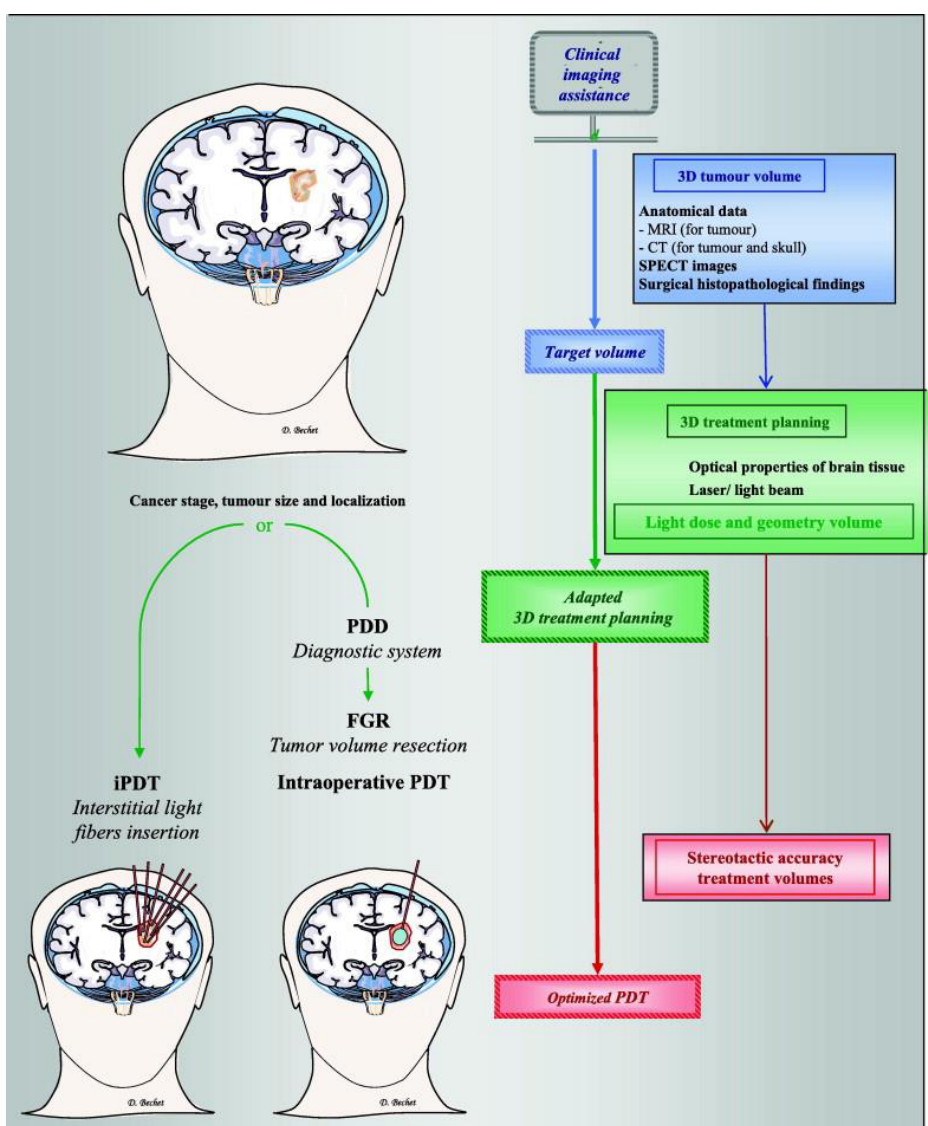
Figure 3. Clinical imaging assistance as an essential step in therapeutic planning. Left side: Two strategies suggested depending on the stage, size, and localization of the tumour. An interstitial PDT (iPDT) or, after a minimally invasive craniotomy, a photodiagnosis (PD) followed by a fluorescence-guided resection (FGR) and completed by an intraoperative PDT. Right side: Clinical imaging assistance plays an essential role in brain tumour PDT, including estimating the initial tumour volume, 3D treatment planning (light dose according to the volume geometry), and outcome assessment. Computed 3D image-based treatment planning provided reproducible data-based tumour volumes, stereotactic accuracy for tumour volume resection, and interstitial light fibre insertion for iPDT. Optical fibres for PDT can be placed under contrast-enhanced computed tomography (CT) guidance, and the surgical approach and trajectories can be planned using preoperative diffusion magnetic resonance imaging (MRI), CT imaging, and/or single-photon emission computed tomography (SPECT) images to achieve precise tumour localization, realize a minimally invasive craniotomy, and minimize controlateral brain injury. Reproduced with permission from D. Bechet, Cancer Treat. Rev. 2014 [88].